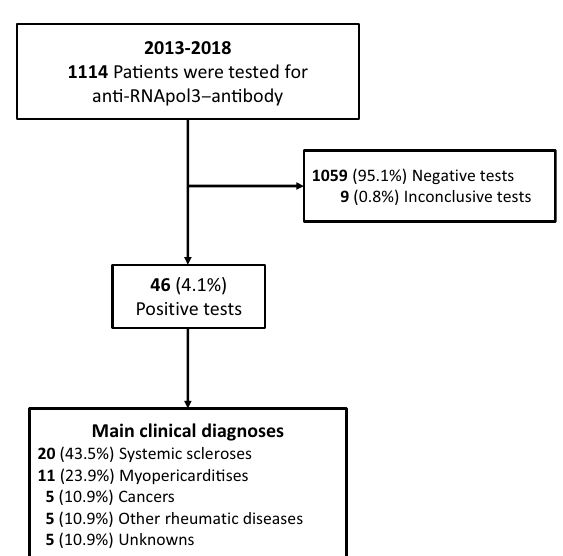
Fig. 1 Flow chart of anti‑RNA Polymerase III (RNApol3) autoantibody detection in individual patients between 2013 and 2018